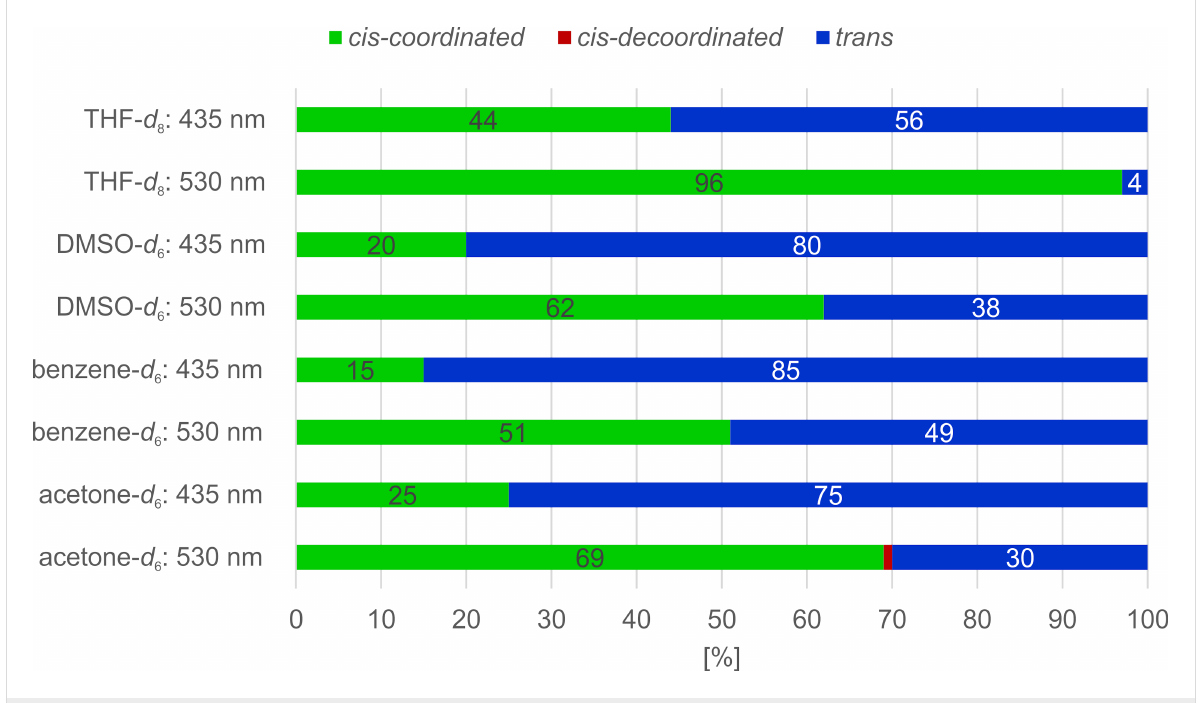
Figure 2: Composition of the different states of porphyrin 1 (1 mM) in the PSS at 530 nm and 435 nm, determined by 1 H NMR spectroscopy (600 MHz; for details, see Supporting Information File